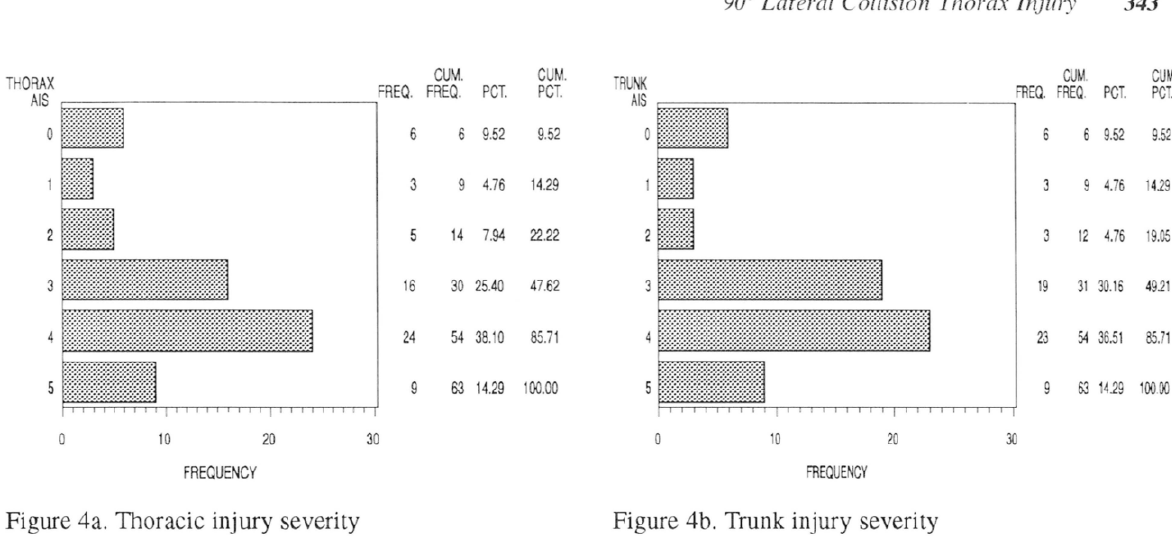
Figure 4a. Thoracic injury severity Figure 4b. Trunk injury severity